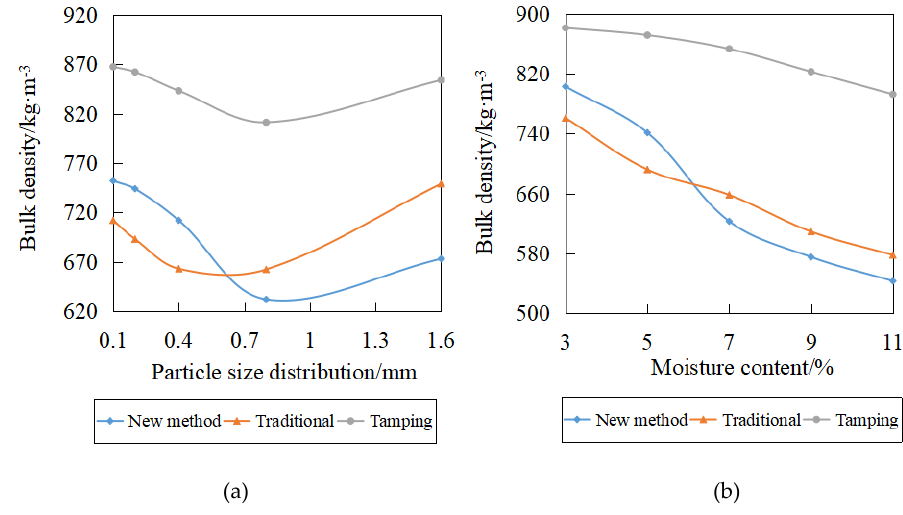
Figure 14. Influence of coking coal characteristics on repose angle. ( a )-The effect of particle size distribution on the bulk density; ( b )-The effect of moisture content on the bulk density.